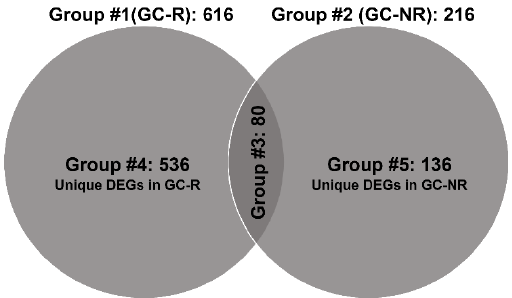
Figure 3. Venn diagram showing differentially expressed gene (DEG) groupings. DEGs of three groups from RNA seq data are shown; only genes with absolute fold change >2 and significant p value <0.05 were included in these groupings. Note: Group #1: DEGs between ETH- and DEX- treated cells of GC-R HTM cells; Group #2: DEGs between ETH- and DEX-treated cells of GC-NR HTM cells; Group #3: common genes between Group #1 and Group #2; Group #4: uniquely ex- pressed genes in GC-R; and Group #5: uniquely expressed genes in GC-NR. The top 50 DEGs from Group #1–Group #5 are shown in Table S5a- S5e, respectively. The top 10 DEGs from Group #3–#5 are given in Table 1. Table 1. List of top 10 up/down-regulated genes.